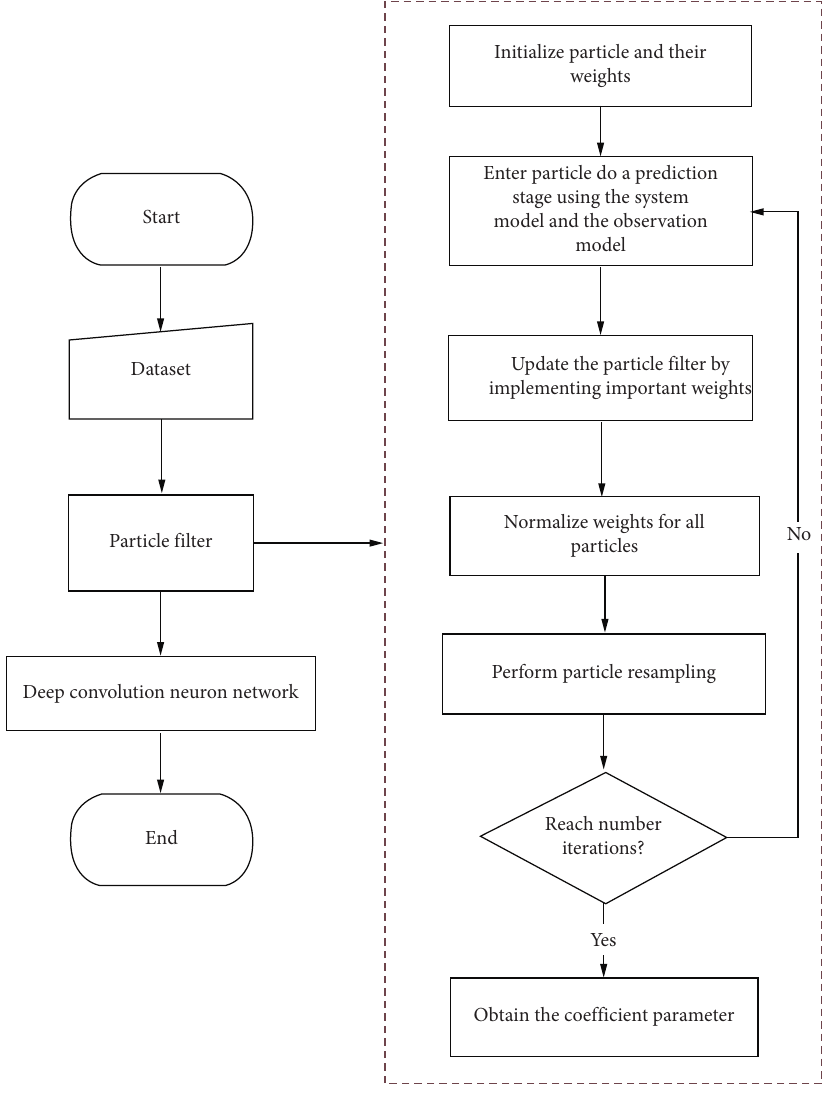
Figure 4: Working processes of the applied method.